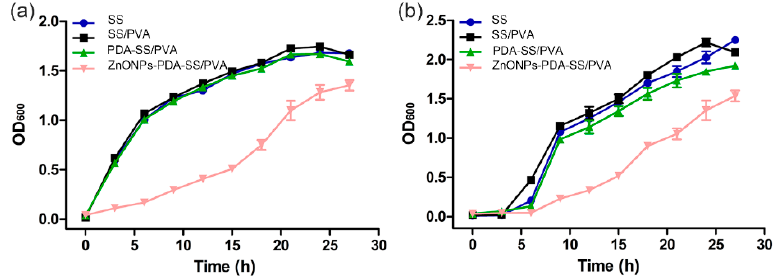
Figure 9. Bacterial growth curves of E. coli ( a ) and S. aureus ( b ) in the presence of different films.